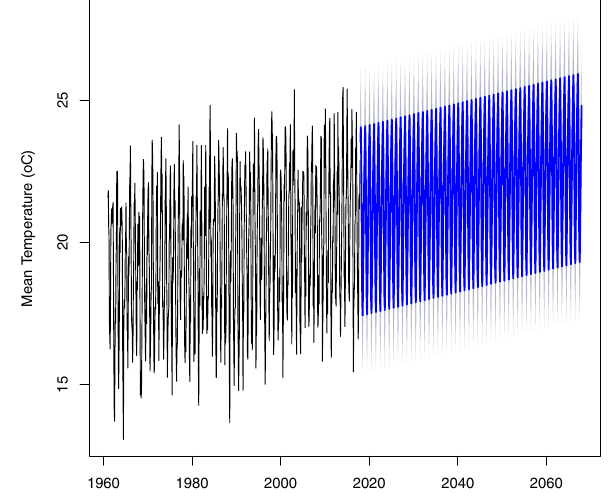
Fig. 4 Observed temperatures in São Paulo City from 1960 to 2017 and forecasts with 95% prediction intervals for the next 50 years using the AR(1) error